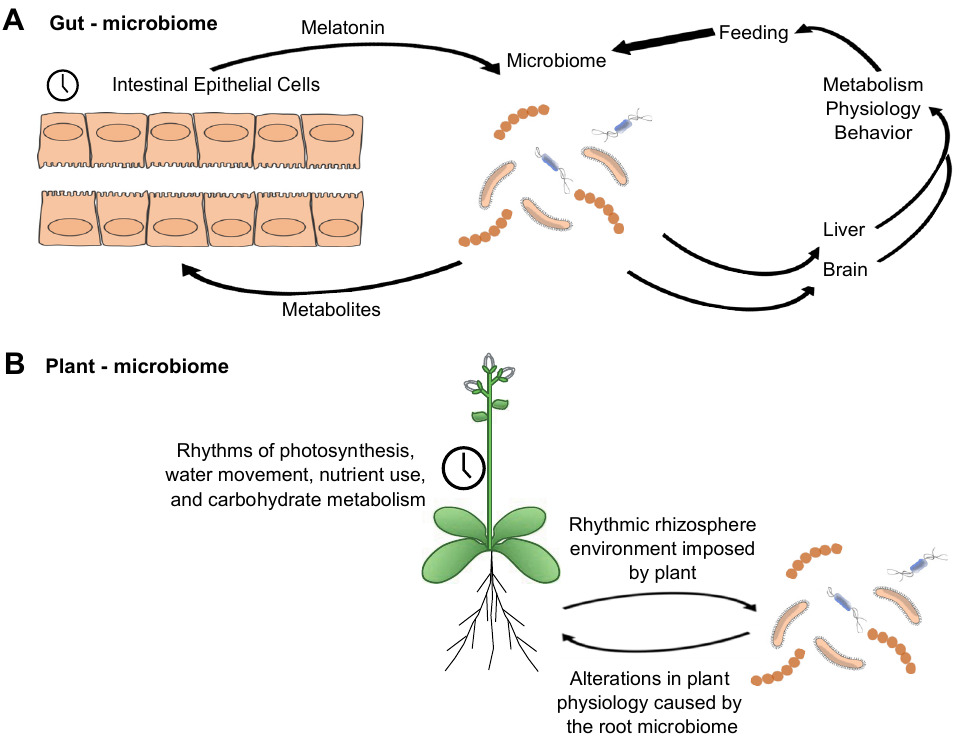
Figure 3. Interactions between circadian clocks and microbiome communities are established. ( A ) The clock in the host (here shown as the intestinal epithelial cells) shapes the gut microbiome community and the microbiome, in turn, impacts many clock-regulated outputs. ( B ) Similar results have started to appear relative to plant microbial communities. It is as yet unclear how much endogenous clock-like function the microbes may possess. We propose that the microbial community may utilize mutualism with a temporal structure in such a way that is consistent with the observations published thus far.